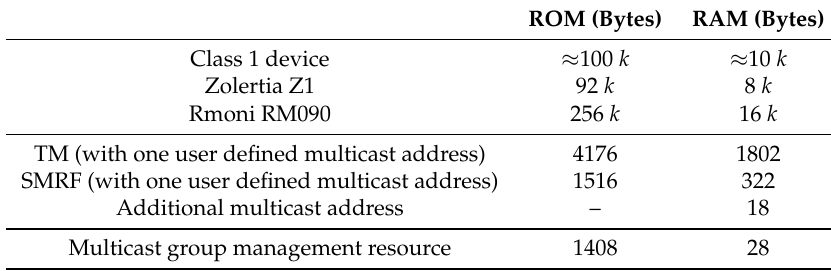
Table 5. Resource availability and requirements. The available resources on sample devices and the requirements for various system components. TM, Trickle Multicast; SMRF, Stateless Multicast RPL